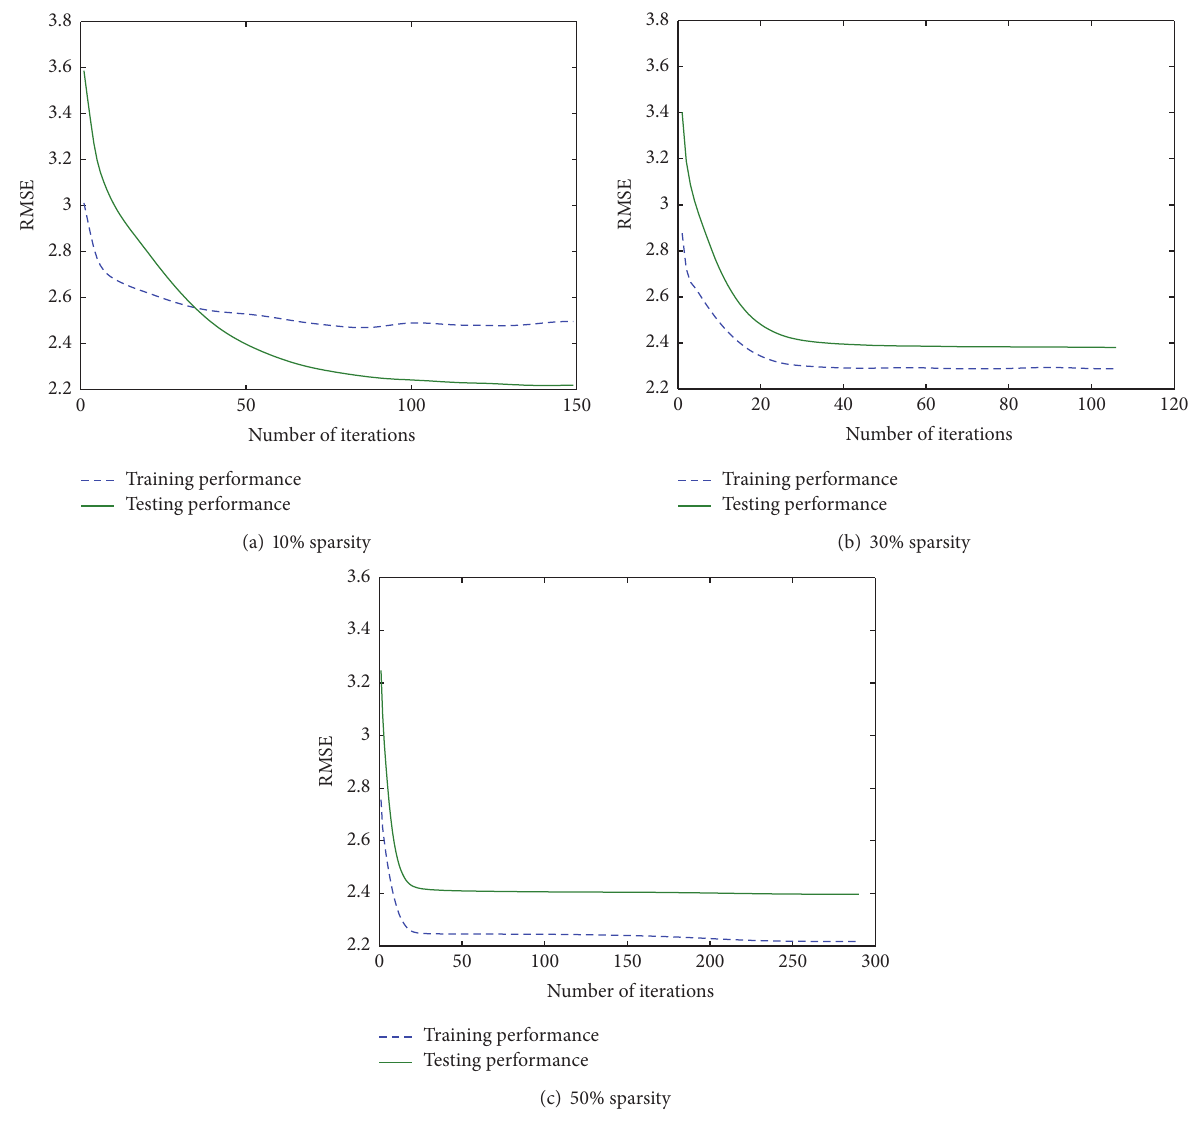
Figure 2: Performance dynamics of the offline TSVD over iteration